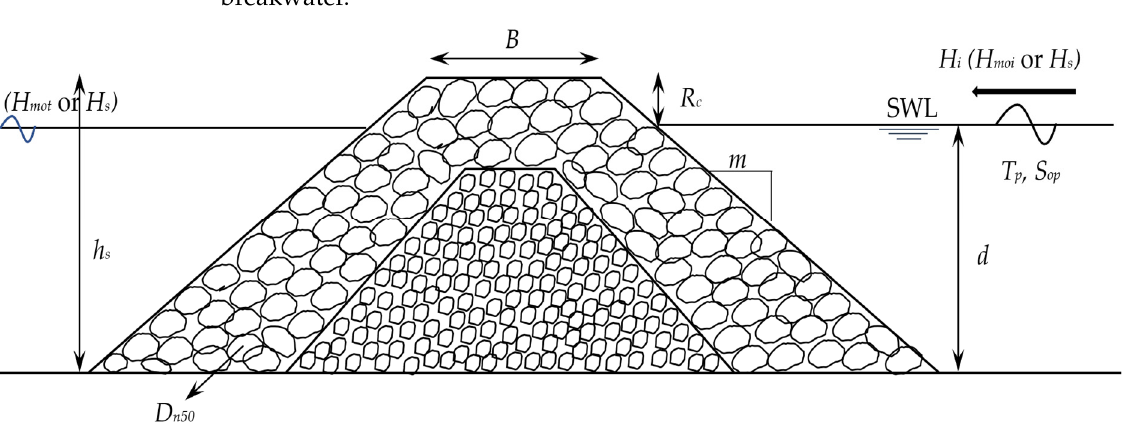
Figure 1. Definition of the parameters involved in wave